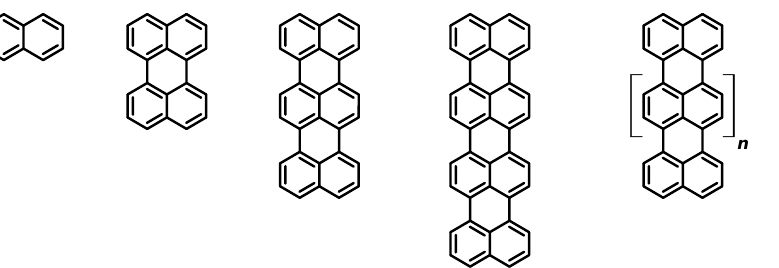
Figure 1. The following are shown from left to right: naphthalene, perylene, terrylene, quaterrylene, and a generical oligorylene.